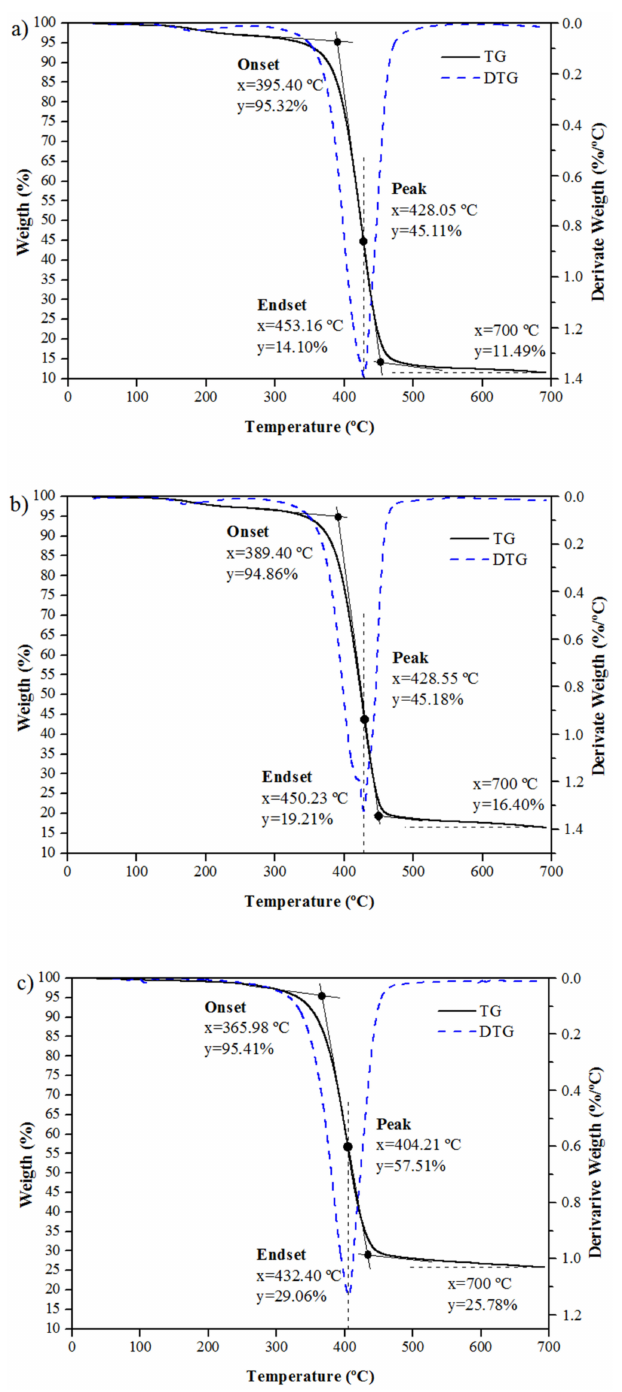
Figure 4. TG and DTG curves of GFRP bars with matrix: ( a ) polyester, ( b ) vinyl ester, and ( c ) epoxy. The TG curves showed a sharp slope at temperatures (T onset ) of 389.4 ◦ C (polyester matrix), 395.4 ◦ C (vinyl ester matrix), and 366.0 ◦ C (epoxy matrix), evidenced by the reduction of the derivative, reaching a well-defined valley in the DTG curve. At the end of this thermal event (T endset ), mass losses equal to 81.22% (polyester matrix), 75.65% (vinyl ester matrix), and 66.35% (epoxy matrix) were observed and were associated with the thermal degradation of the polymer